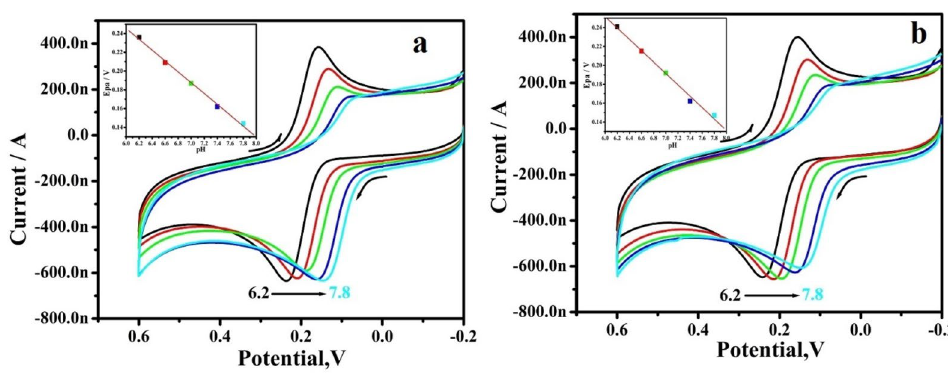
Figure 8. (a) CVs for different pH of 10 μM DA in 0.2 M PBS at RGO-Y 2 O 3 MCPE, ( b) CVs for different pH of 10 μM DA in 0.2 M PBS RGO-Y 2 O 3 ; Cr 3+ MCPE. The inset figure ( a , b) shows the graph of Epa v/s